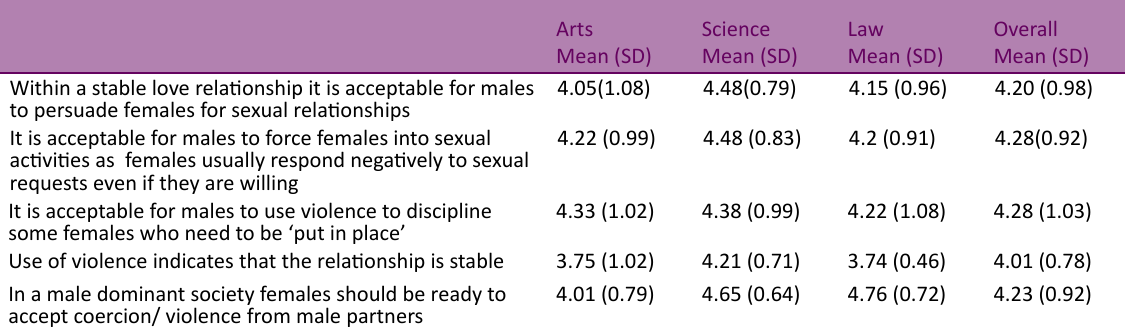
Table 3 – Mean score (SD) on attitudes of female students of the three Faculties on use of coercion or violence by males within romantic or sexual